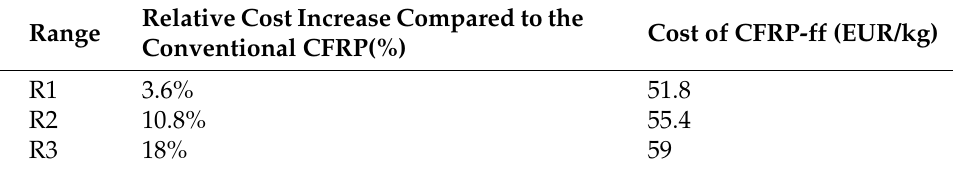
Table 13. Parameters used for sensitivity analysis of the repair business of paddle shifters made from CFRP-ff. The conventional CFRP cost is 50 EUR/kg.